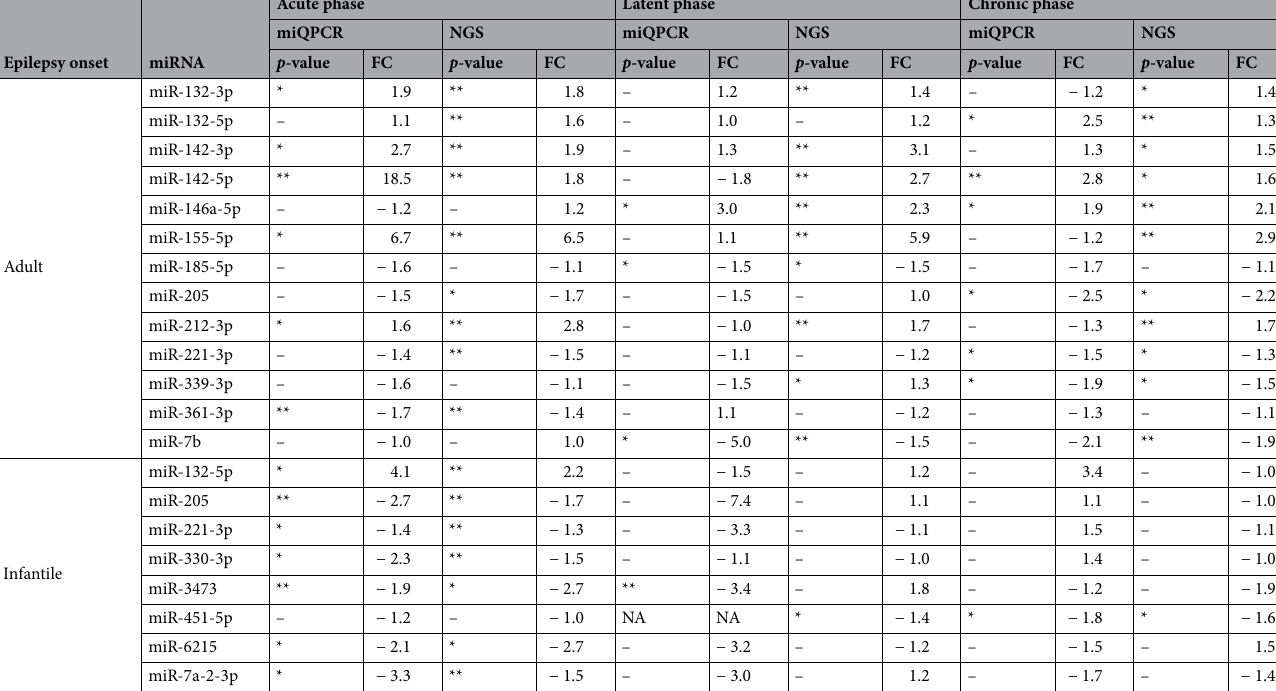
Table 2. Differentially expressed miRNAs in infantile-onset and adult-onset TLE. List of miRNAs with altered regulation (fold-change over 1.4) confirmed by miRNA sequencing (DESeq2) and miQPCR. 13